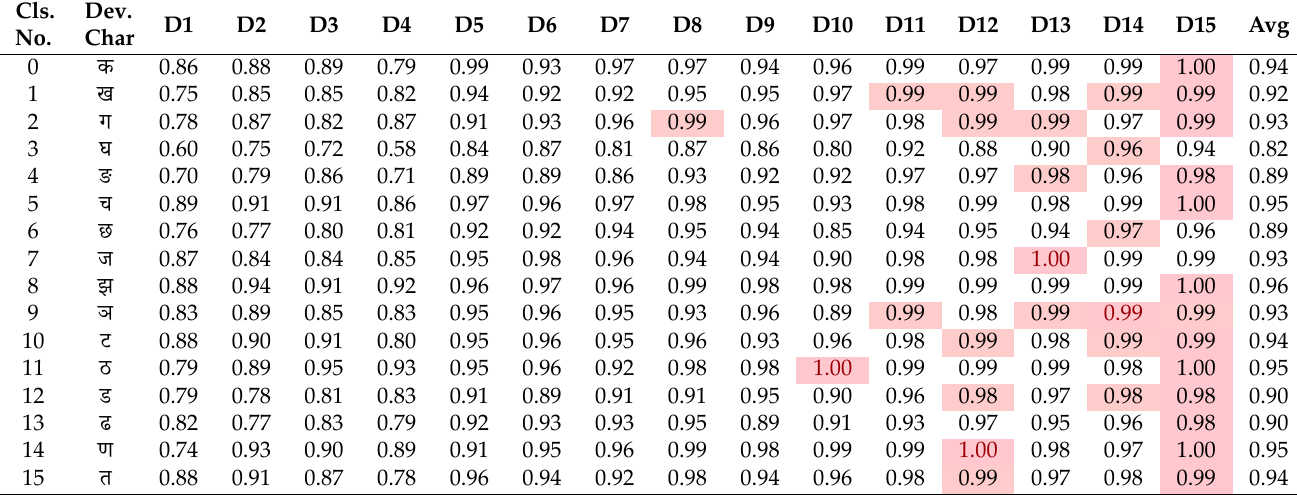
Table 12. Character‑wise F1 score produced by an SVM classifier for the proposed datasets.